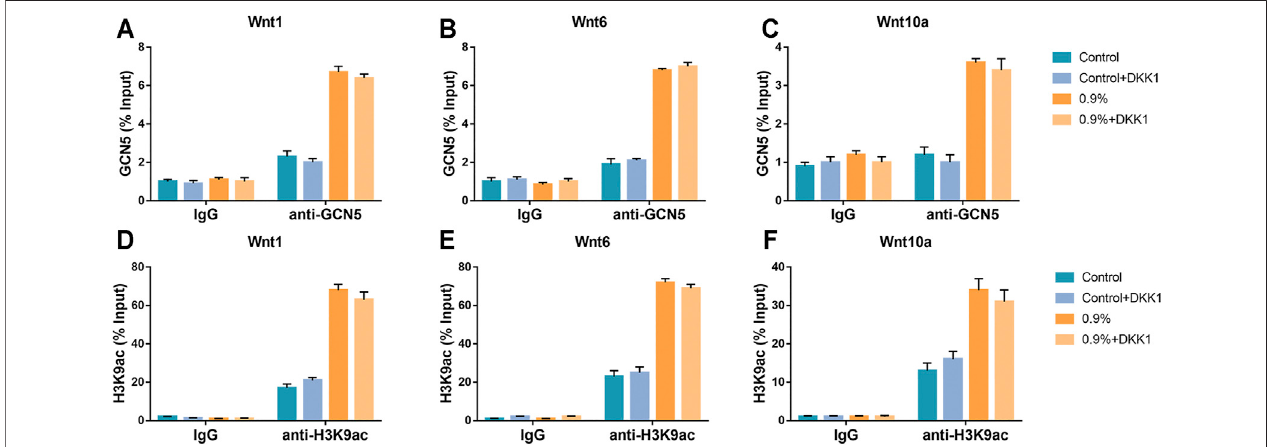
FIGURE 8 | DKK1 could not inhibit GCN5 function. (A – C) The ChIP assay was performed to evaluate the combination of GCN5 to Wnt1, Wnt6, and Wnt10a promoters with DKK1 treatment and non – DKK1 treatment. (D – F) The ChIP assay was performed to evaluate the enrichment of H3K9ac to Wnt1, Wnt6, and Wnt10a promoter regions with DKK1 treatment and non – DKK1 treatment. Values are plotted as mean ± SD, * p < 0.05, ** p < 0.01.